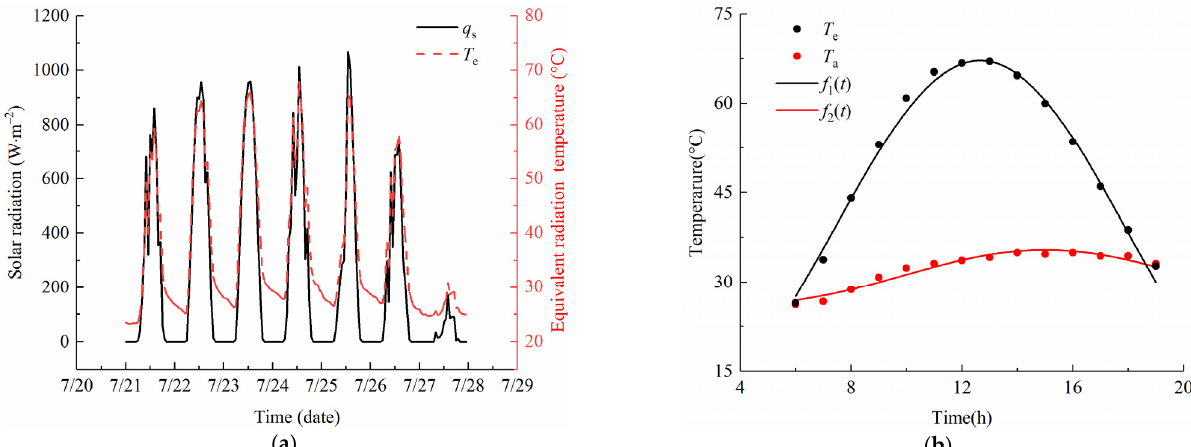
Figure 11. Time history curves of environmental parameters. ( a ) Measured data of the equivalent radiation temperature and solar radiation from 21 to 27 July 2020; ( b ) Fitting results of the equivalent radiation temperature and air temperature on 23 July 2020.